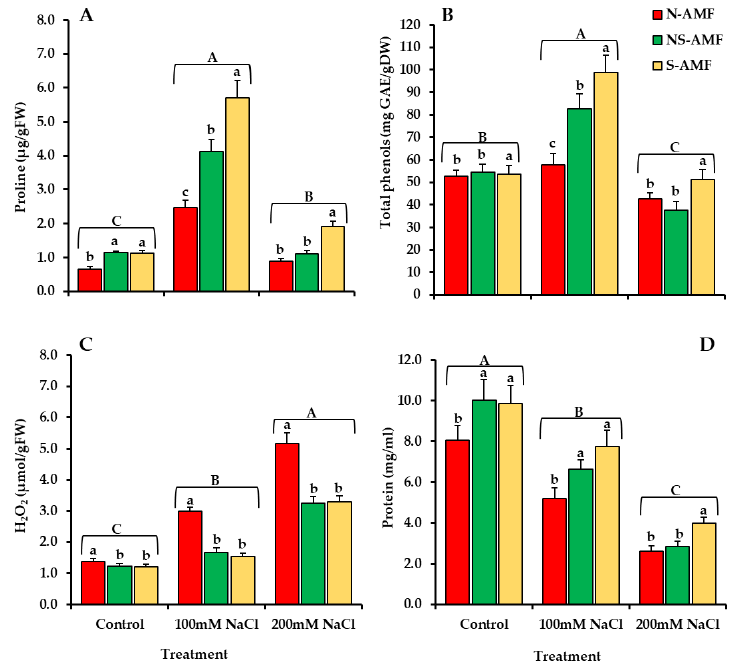
Figure 6. Influence of AM symbiosis (S-AMF and NS-AMF) on the proline (ug/gFW) ( A ), total phe- nols (mg GAE/gDW) ( B ), hydrogen peroxide (H 2 O 2 umol/gFW) ( C ), and protein (mg/gFW) ( D ) con- tents of L. scindicus plants under different levels of salinity. Capital letters indicate the significance of the salinity effect, while small letters indicate the effect of AM symbiosis at p = 0.05 (Tukey’s HSD test).